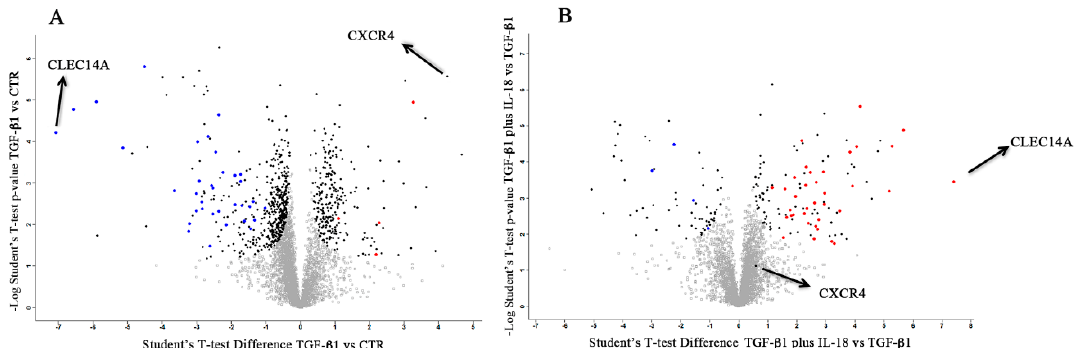
Figure 6. Proteomic analysis of NK cells unconditioned or conditioned with TGF- β 1 (vs. CTR) or TGF- β 1 plus IL18 (vs. TGF- β 1). Volcano plot representations of differentially expressed proteins relative to TGF- β 1 vs. CTR (unstimulated) ( A ) or TGF- β 1 plus IL-18 vs. TGF- β 1 data sets. ( B ) Black dots represent proteins that display both large magnitude fold-changes ( x -axis, proteins upregulated after treatment are shown on the right) as well as high statistical significance (FDR = 0.05 and s0 = 0.1 log10 of P value, y -axis). Colored plots represent 40 proteins more significantly downregulated (blue) or upregulated by TGF- β 1 treatment (vs. CTR) o by TGF- β 1 plus IL-18 (vs. TGF- β 1). Gray squares represent proteins not significantly modulated by the treatments. CXCR4 and CLEC14A proteins are indicated in both volcano plots .